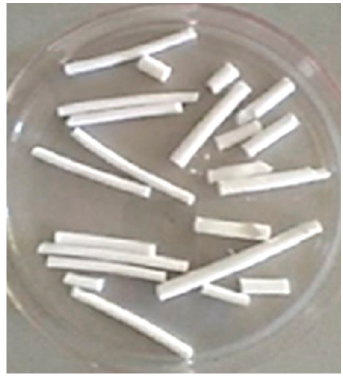
Figure 7. Mono-ICE samples.